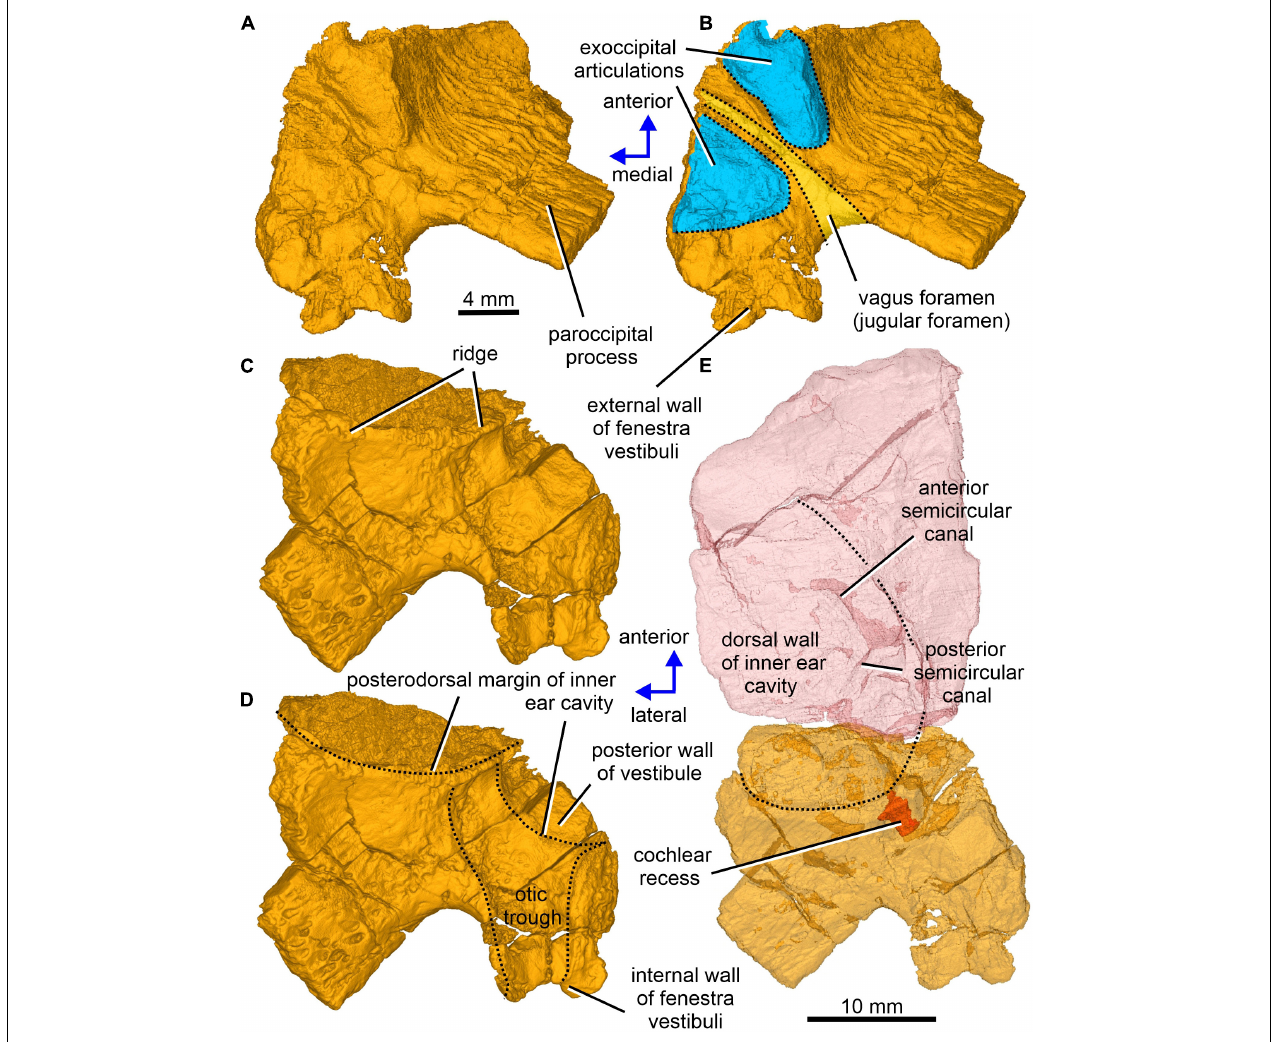
FIGURE 6 | Limnoscelis dynatis, CM 47653. (A–D) Right opisthotic in dorsal and slightly anterior view (A,B) and ventral and slightly anterior view (C,D) . (E) Right semitransparent supraoccipital and opisthotic in ventral